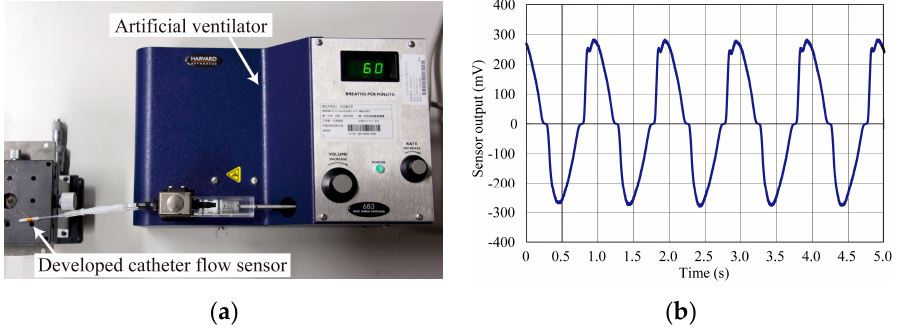
Figure 6. Oscillating airflow measurements by artificial ventilator: ( a ) Experimental setup; ( b ) Measured waveform by catheter flow